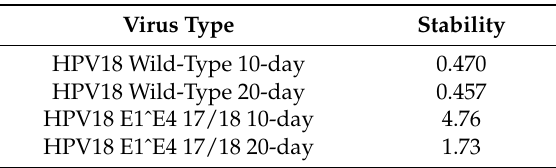
Table 1. Relative stability values of 10- and 20-day wild-type (WT) and human papillomavirus type-18 (HPV18) E1ˆE4 17/18 mutant virus. Stability values were calculated by dividing the ratio of total genomes in the unstable fractions (fractions 1–4) by the total genomes in the stable fractions (fractions 6–9). The lower the number, the more stable the